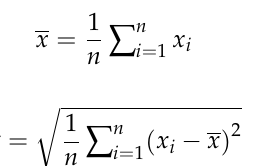
Figure 6. Feature variations in the discharging stage related to cycles.